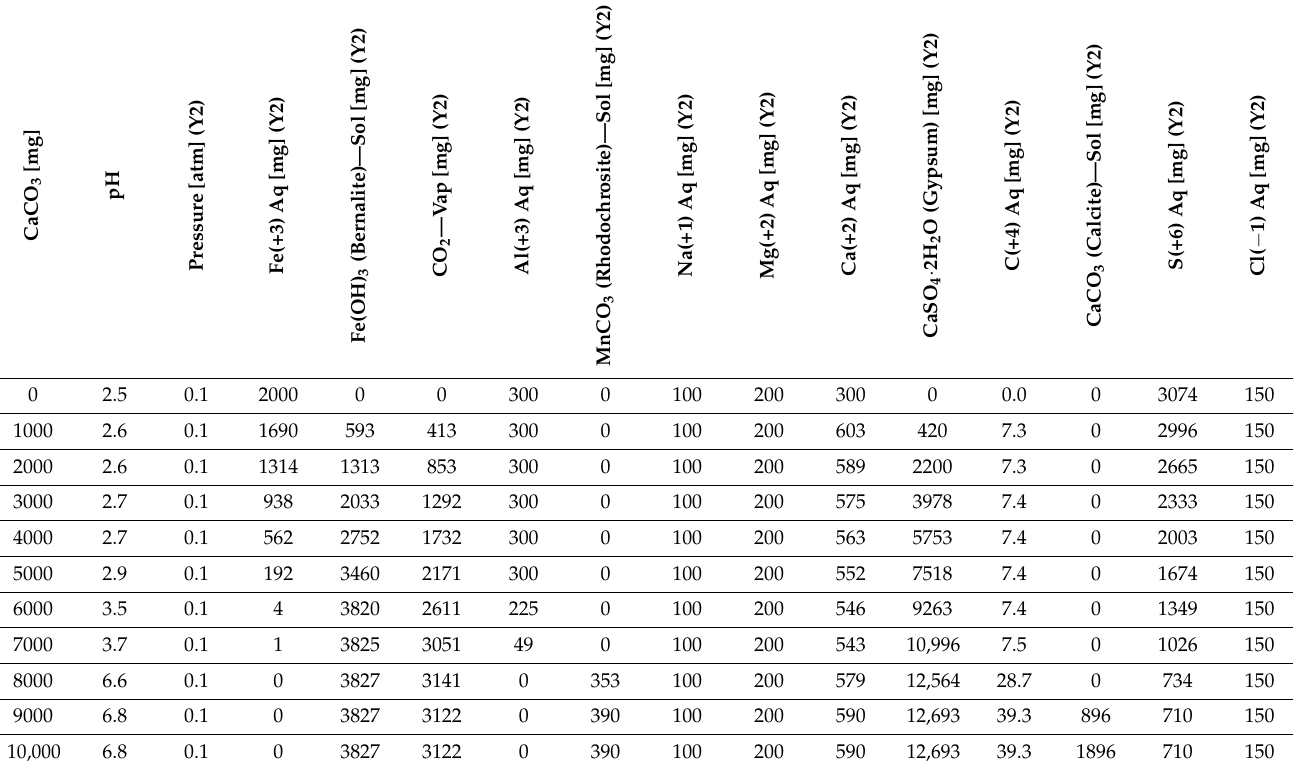
Table 5. Removal of Fe 3+ and other metals with only CaCO 3 at 0.1 atm (OLI